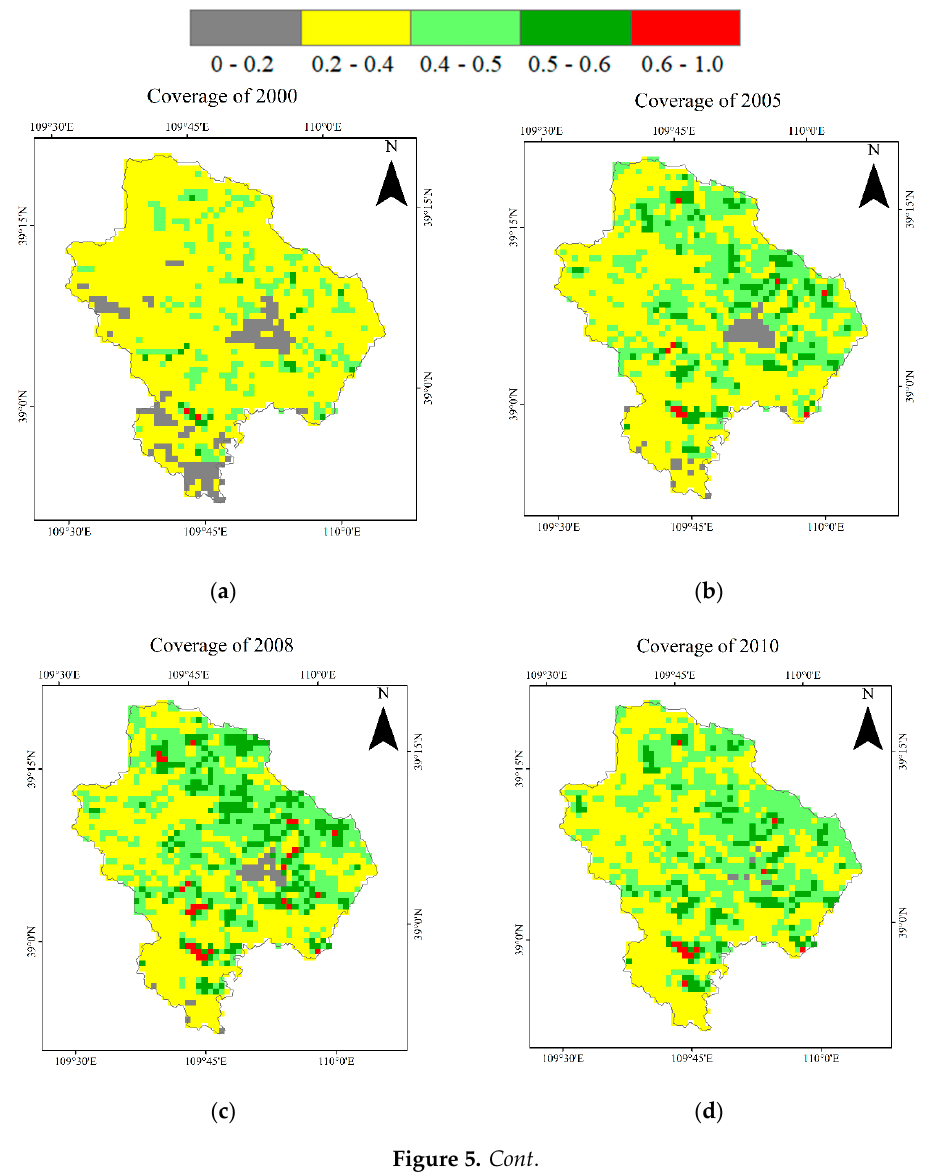
Figure 4. Average VC change in six counties (Shenmu, Ejin Horo Banner, Yuyang District, Wushen, Dongsheng District, and Fugu) during